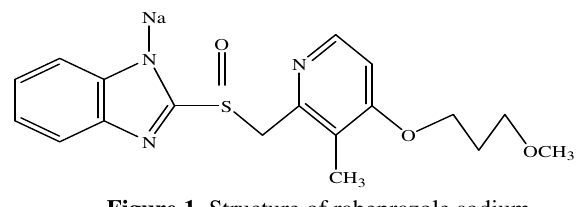
Figure 1 . Structure of rabeprazole sodium.